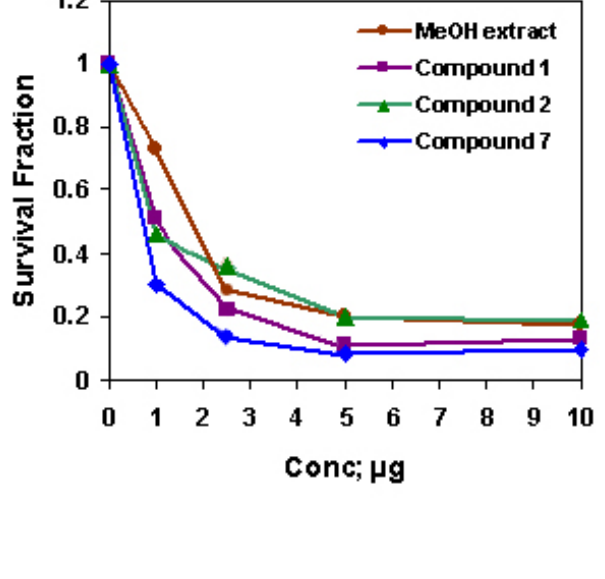
Figure 4. The cytotoxic activity of D. repens MeOH extract, 1 , 2 and 7 against HepG2 cell